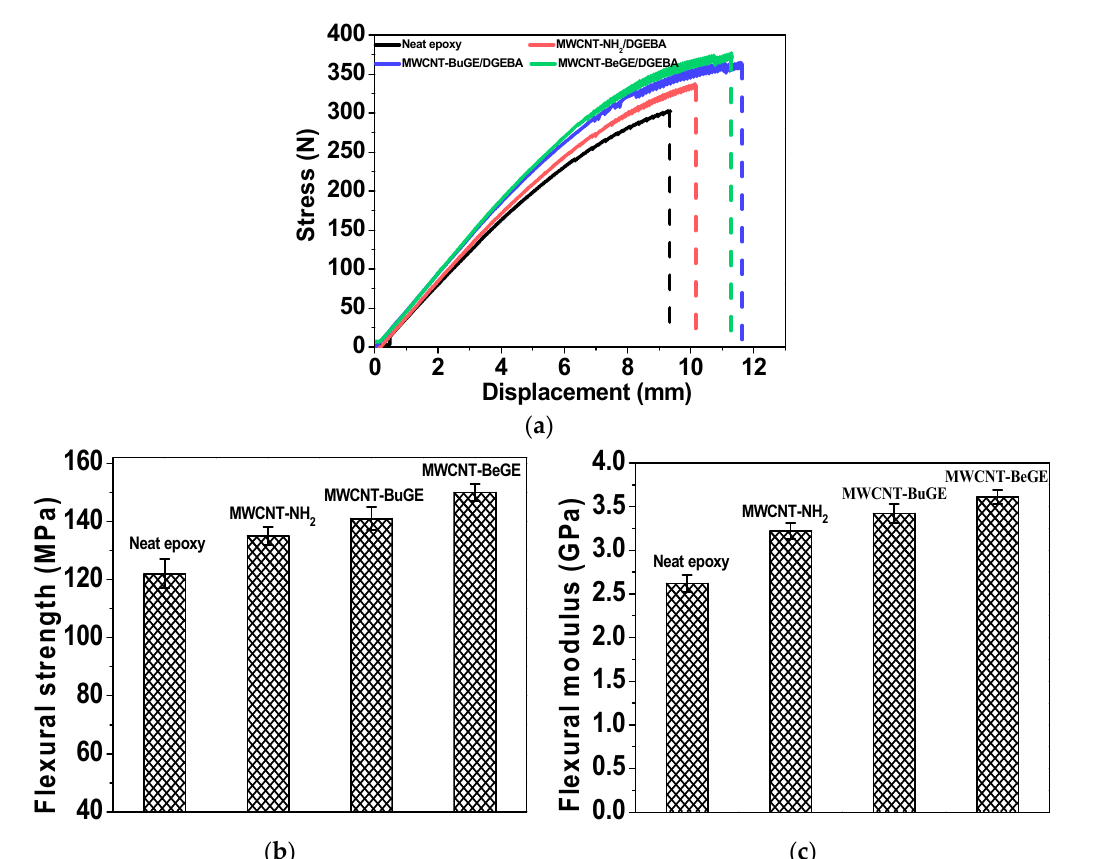
Figure 12. ( a ) Typical flexural stress-displacement curves, ( b ) the corresponding flexural strength and